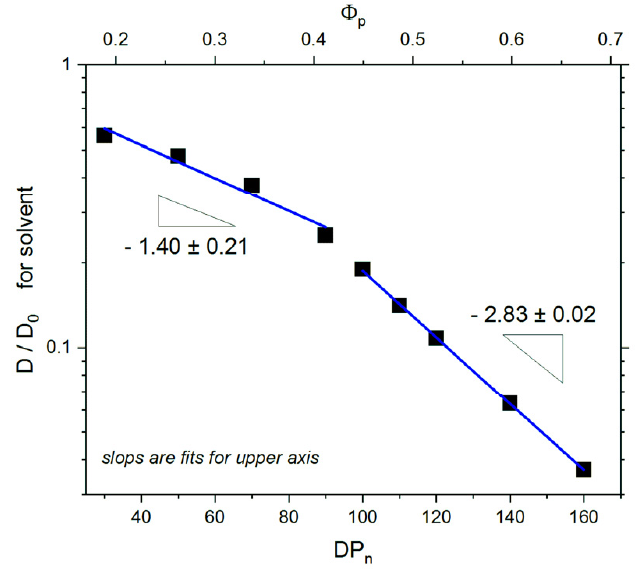
Figure 7. Reduced self-diffusion coefficient D / D 0 for solvent as a function of the degree of polymer- ization DP n . The case of σ = 0.3.